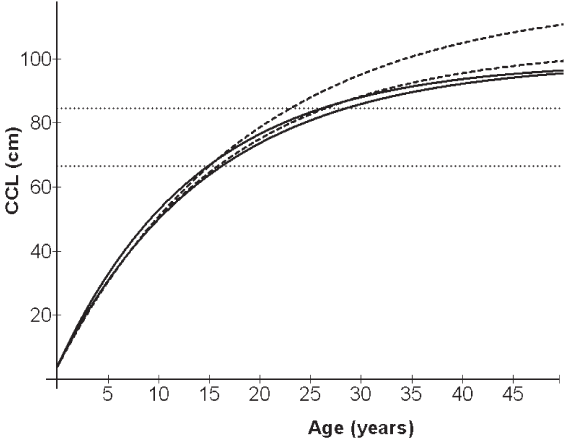
Fig . 6. – The von Bertalanffy growth functions as described in Table estimated (dashed lines) or fixed at 99 cm CCL (solid 1, with L ∞ lines). In both cases, the upper curves were obtained with the growth rate (GR) method and the lower curves were obtained with the age at size (AS) method. Horizontal dashed lines show the range of mean curved carapace lengths (CCL) of Mediterranean nesting females (Margaritoulis et al ., 2003): 66.5 and 84.7 cm CCL.